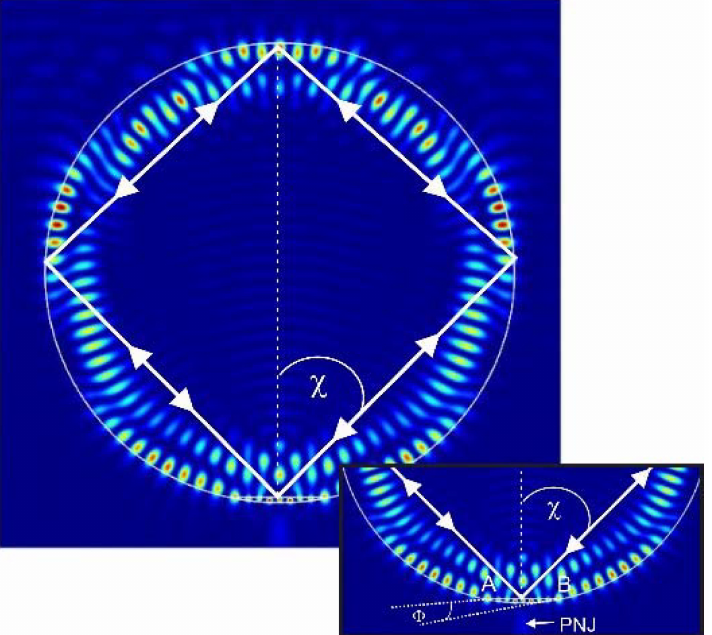
Figure 3. The path of the rays in a Janus particle in the case of a ray falling on a flat surface at an angle of total internal reflection χ . The inset shows a schematic change in the phase of a wave along a section of a flat